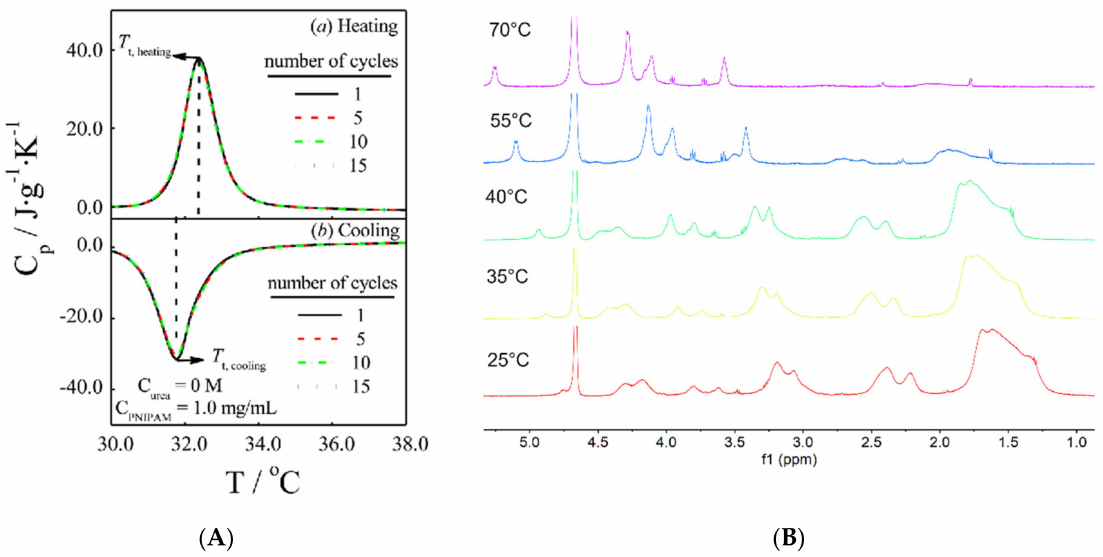
Figure 7. ( A ) Differential scanning calorimetry thermograms of PNIPAM aqueous solution (1.0 mg/mL) during four different heating − cooling cycles (cycles 1, 5, 10 and 15). Heating and cooling rates were both 1.00 ◦ C/min. Reproduced with permission from Gao [171], copyright by ACS Publications, 2014. ( B ) 1 H NMR spectra of chitosan-graft-poly- N - vinylcaprolactam in D 2 O recorded at different